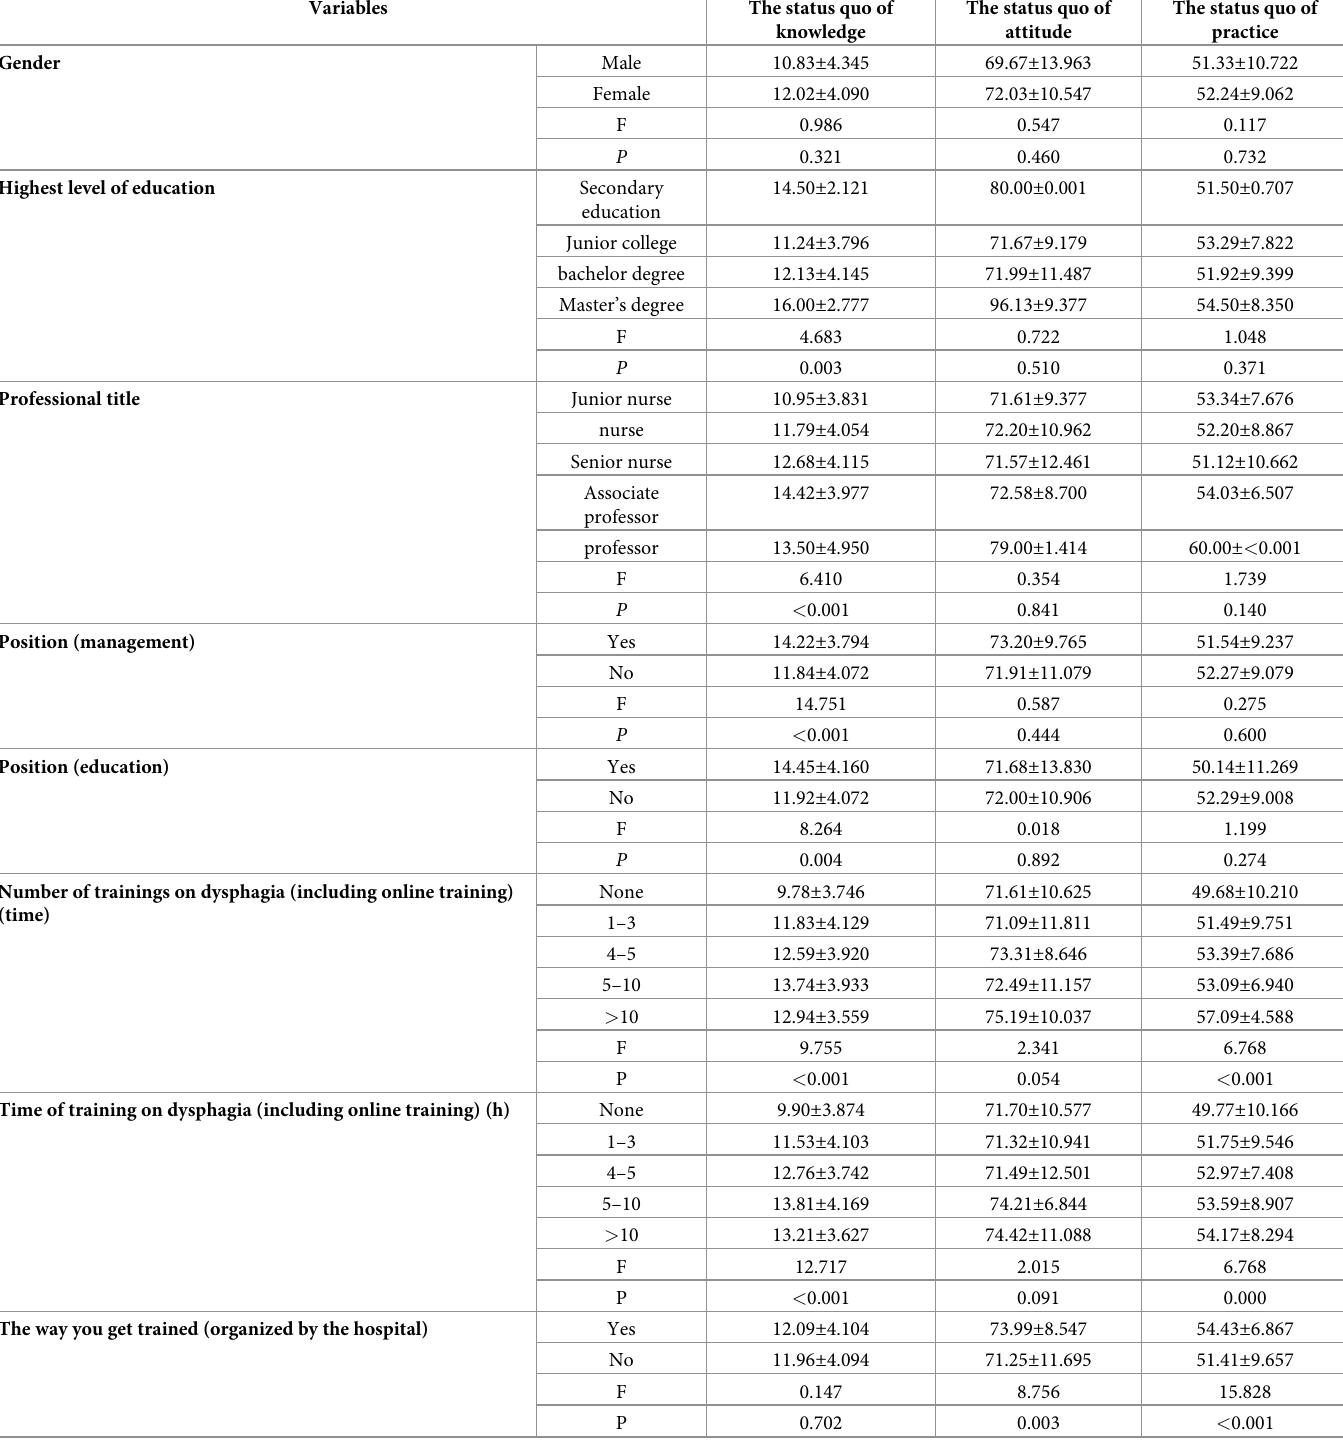
Table 3. Factors associated with the status quo of KAP (categorical